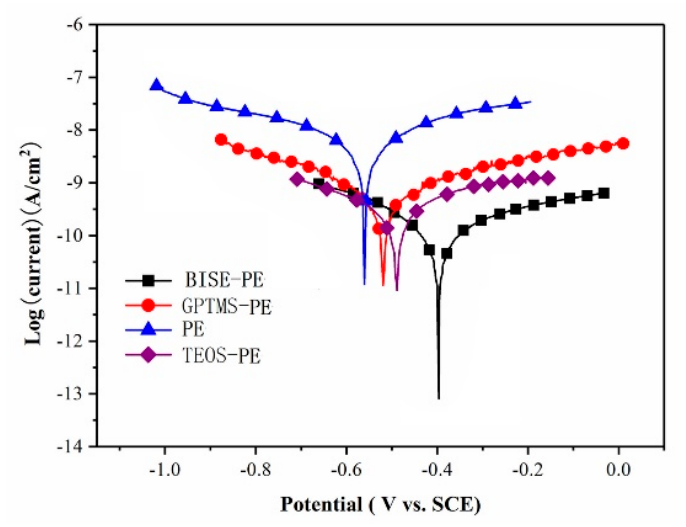
Figure 1. Polarization curves of an Al − alloy coated with different PE-coatings.